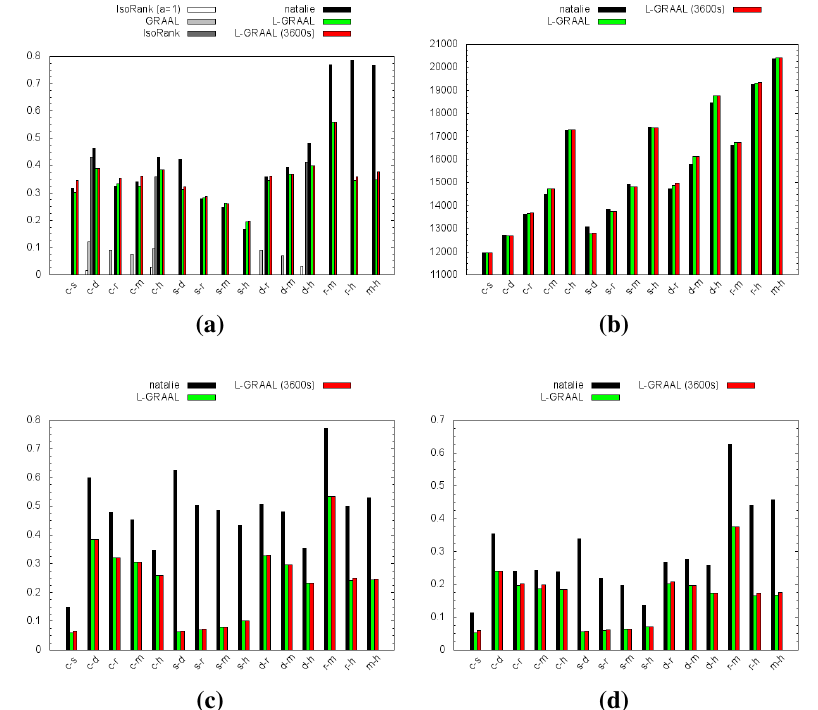
Figure 2. Performance of the four different methods for all-against-all species comparisons (15 alignment instances). Missing bars correspond to exceeded time/memory limits or software crashes. For LCC, ICS and S3 only Natalie 2.0 and L-GRAAL were compared. ( a ) Edge correctness (EC); ( b ) Size of largest connected component (LCC); ( c ) Induced Substructure Score (ICS); ( d ) Symmetric Substructure Score